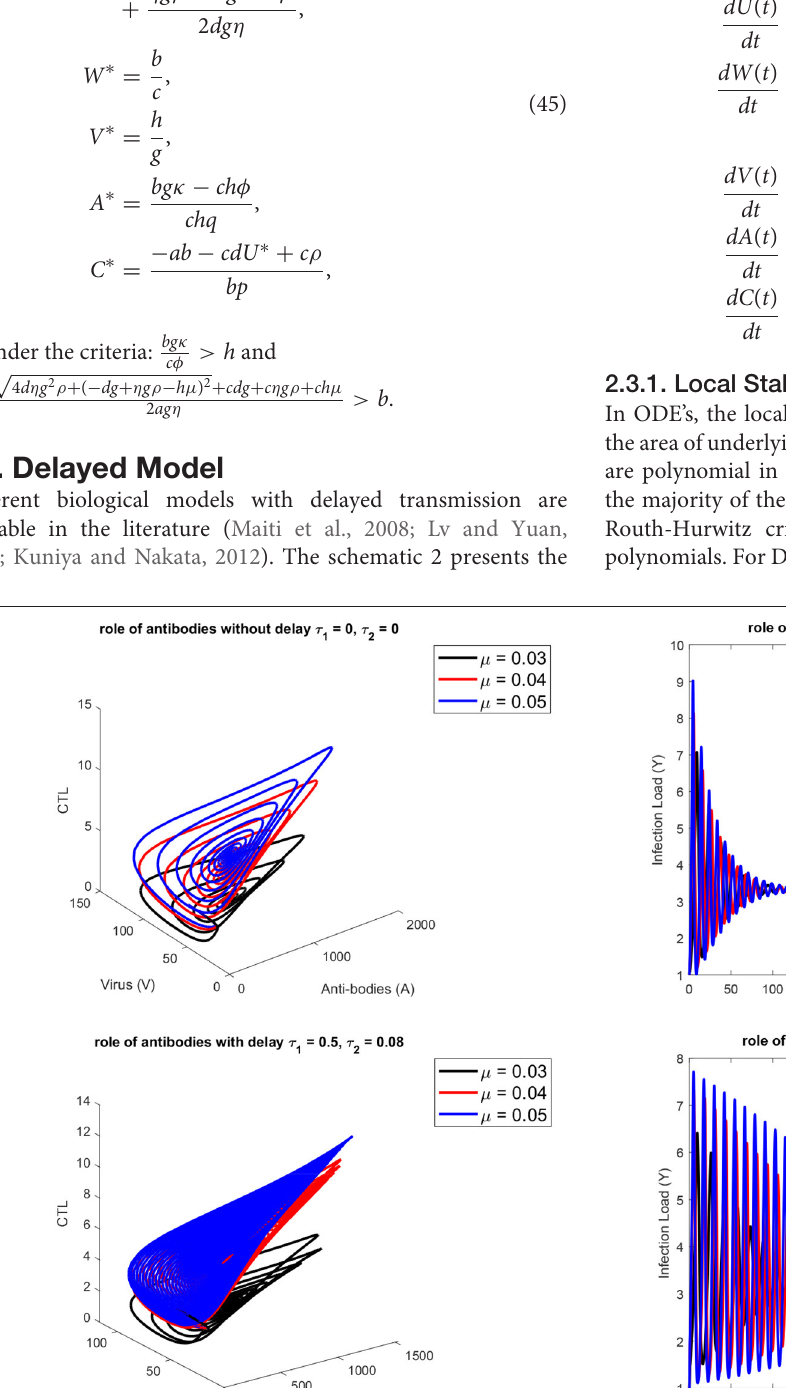
FIGURE 3 | For three different values of the replication rate of virus. (Top) without, (Bottom) with delay τ 1